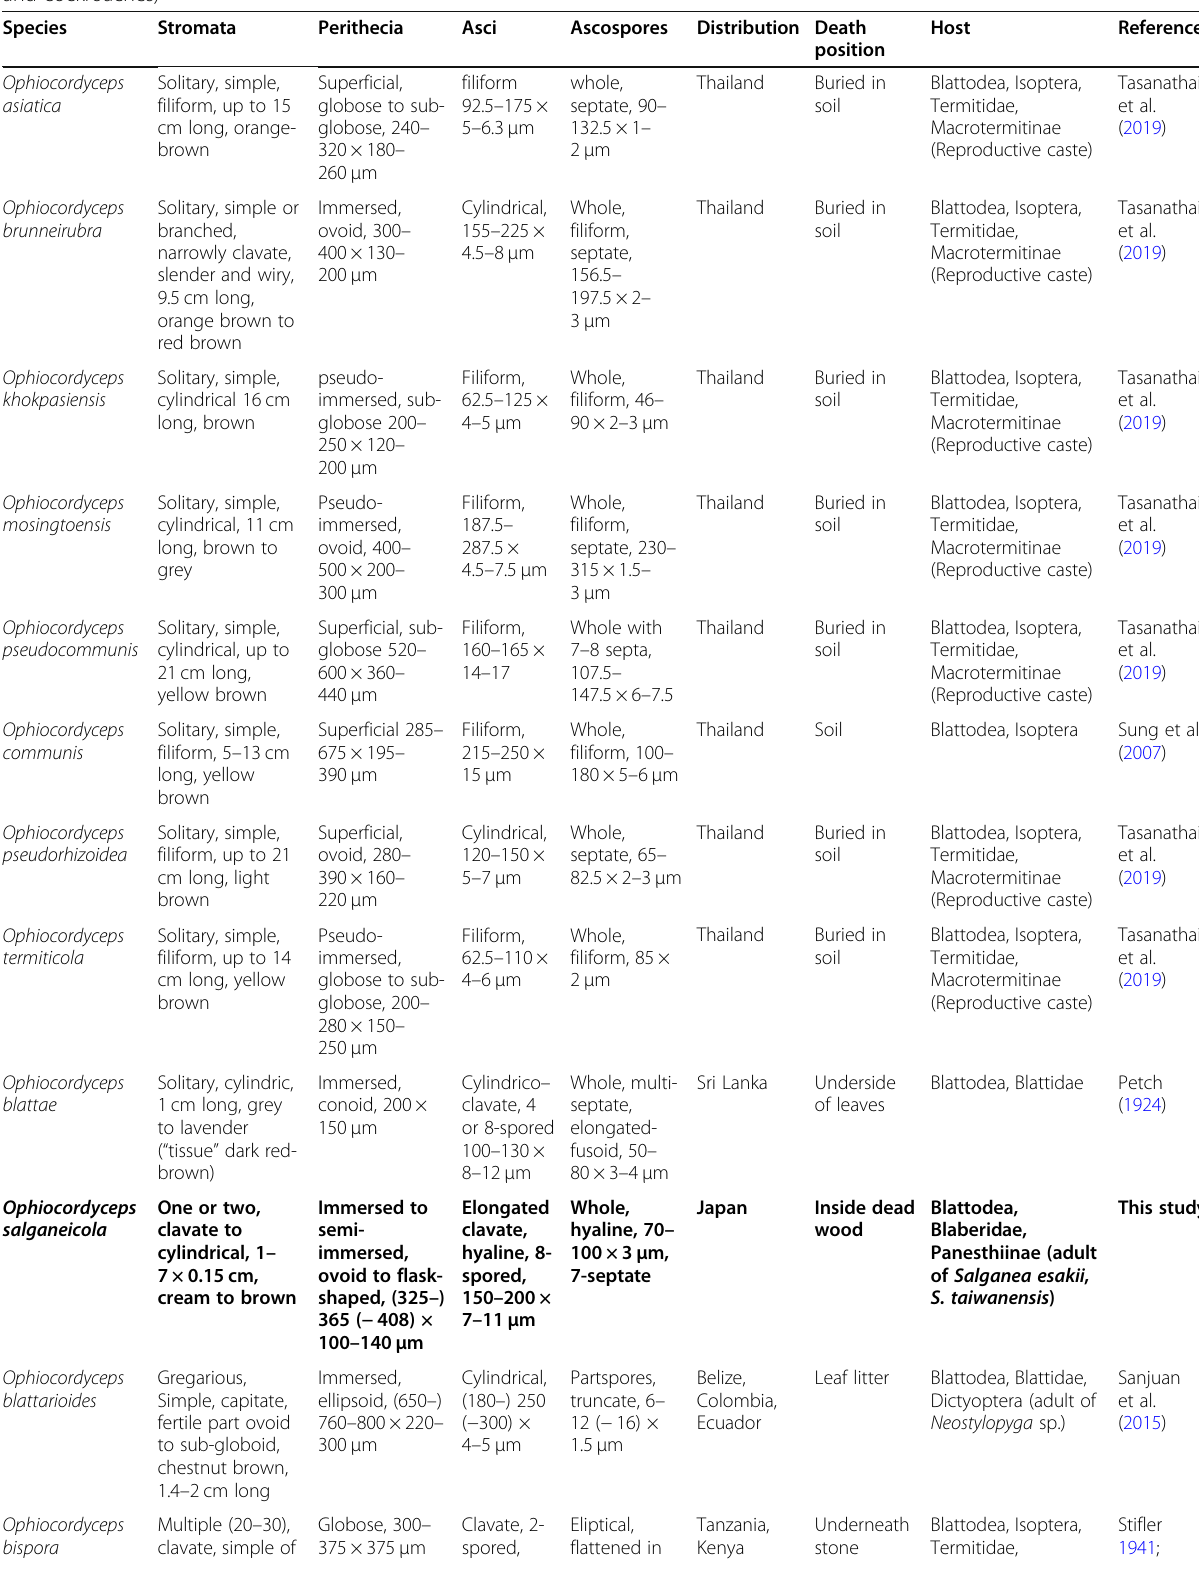
Table 2 Morphological and ecological comparison between Ophiocordyceps species associated with blattodean insects (termites and